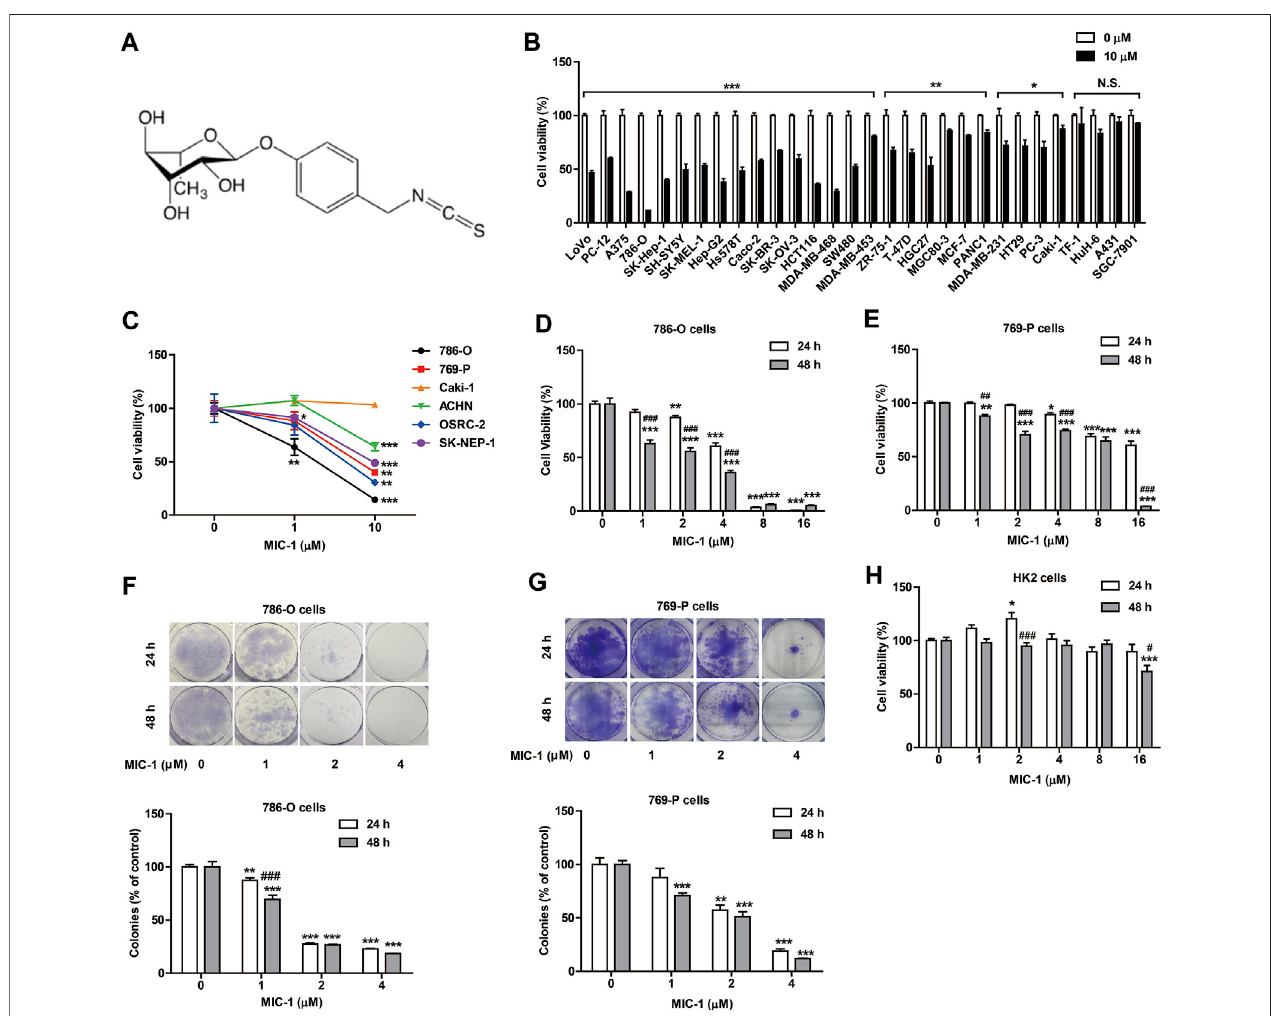
FIGURE 1 | MIC-1 inhibits the growth of RCC cells. (A) The molecular structure of MIC-1. (B) The viability of 30 types of cancer cells following MIC-1 (0 or 10 μ M) treatmentfor48 h. (C) Theviabilityofsixtypes ofrenalcancercellsfollowingMIC-1(0, 1,or10 μ M)treatmentfor48 h. Theviabilityof786-Ocells (D) and 769-Pcells (E) treated with different concentrations of MIC-1 (0, 1, 2, 4, 8, or 16 μ M) for 24 or 48 h. Clonogenic ability of 786-O cells (F) and 769-P (G) was analyzed by a colony formationassay.CellswereincubatedwithMIC-1(0,1,2,or4 μ M)for24or48 h. (H) TheviabilityofHK2cellstreatedwithdifferentconcentrationsofMIC-1(0,1,2, 4, 8, or 16 μ M) for 24 or 48 h. Values represent the means ± SEM from three independent experiments and statistical analysis was performed by unpaired two-tailed Student ’ sttests,one-wayANOVA,ortwo-wayANOVA;* p < 0.05,** p < 0.01,*** p < 0.001:MIC-1comparedwiththecontrol(0 μ M); # p < 0.05, ## p < 0.01, ### p < 0.001: 48 h compared with 24 h at the same MIC-1